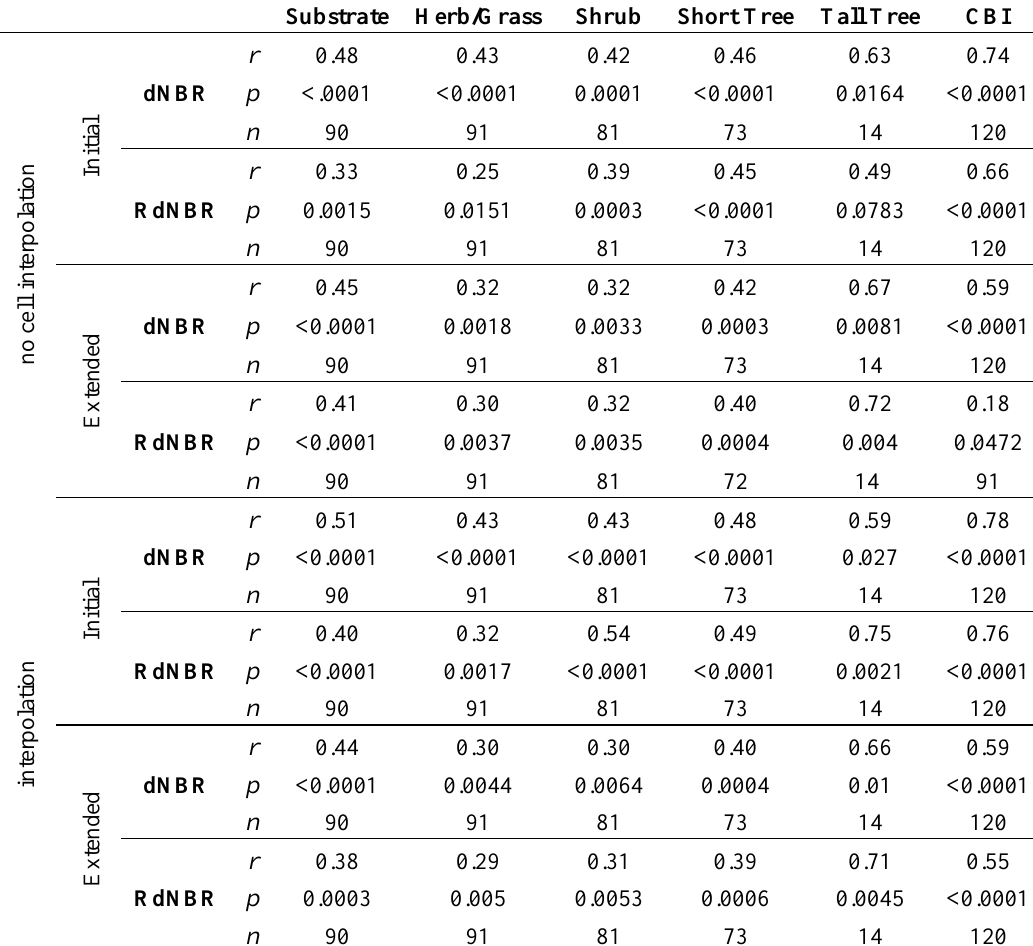
Table 2. Pearson correlations ( r ), p -values ( p ), and sample sizes ( n ) among satellite-derived burn severity classifications and stratum scores and the composite burn index (CBI). Correlations do not include unburned